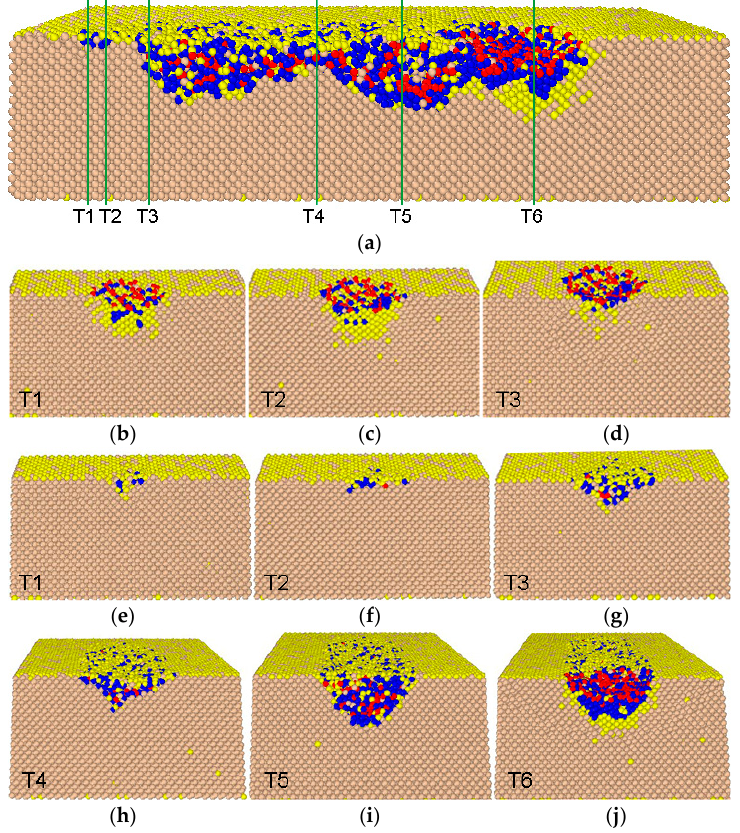
Figure 6. ( a ), whole cross-section view of phase distribution induced by rolling of particle with axial ratio 0.80; ( b – d ), cross-section view of initial loading region labelled by T1–T3 before the top substrate moving and ( e – g ) after the top substrate moving; ( h – j ), cross-section view of particle lying region (T4), particle upright region (T5) and particle occupying region (T6). Atomic color is similar to that coding in Figure 2.